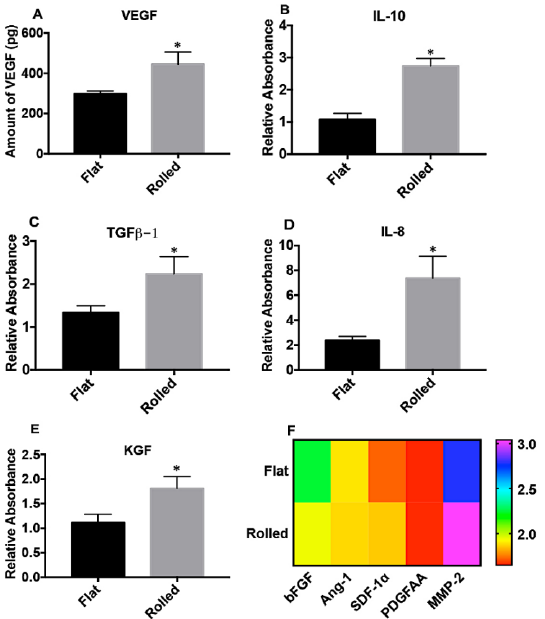
Figure 4. A DC scaffold in rolled configuration modulates the paracrine function of hiPSC-VSMCs. hiPSC-VSMCs embedded in DC scaffolds in a rolled configuration for 72 h exhibited hypoxia and affected the cells’ secretory function. Qualitative ELISA was performed on conditioned media collected from flat and rolled scaffolds for ( A ) VEGF ( n = 6, Rolled vs. Flat p < 0.003), ( B ) IL-10 ( n = 6, Rolled vs. Flat p < 0.0001), ( C ) TGFβ ( n = 6, Rolled vs. Flat p < 0.004), ( D ) IL-8 ( n = 6, Rolled vs. Flat p < 0.0008), and ( E ) KGF ( n = 6, Rolled vs. Flat p < 0.004); ( F ) heatmap showing bFGF, SDF-1α, Ang-1, PDGF-AA, and MMP-2 ( n = 6, Rolled vs. Flat p > 0.05). Conditioned medium (CM) from acellular scaffold was used as a control. Statistical analysis was performed using the student t -test. * denotes statistical